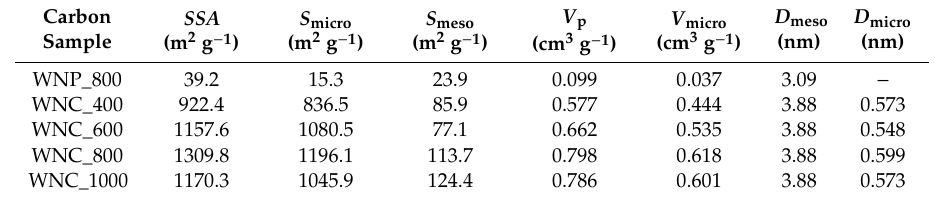
Table 1. Surface textural properties of the Washnut seed-derived nanoporous activated